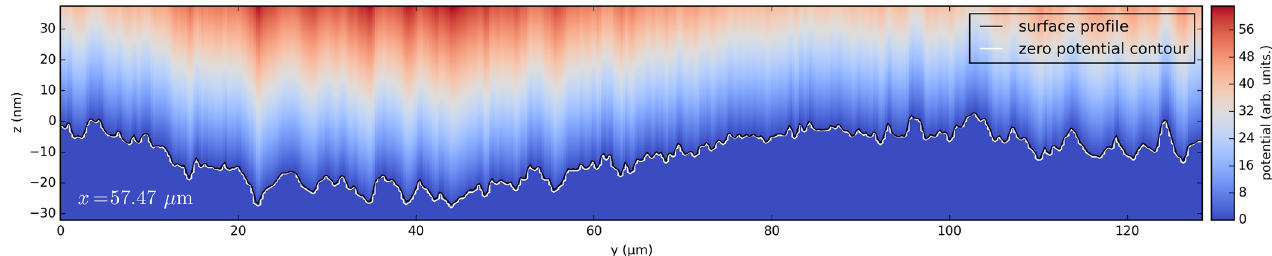
FIG. 8. Validation of the accuracy of the analytical electric potential. We take the profile of the 3D surface shown in Fig. 10 along x ¼ 57 . 47 μ m, the surface profile is marked by the black bold curve. The white bold curve in the plot is the zero potential contour of the analytical electric potential in the y - z plane at x ¼ 57 . 47 μ m, which is calculated by the equations. In the plot, the surface profile and the zero potential contour are mostly overlapped, therefore we conclude that the analytical electric potential is quite